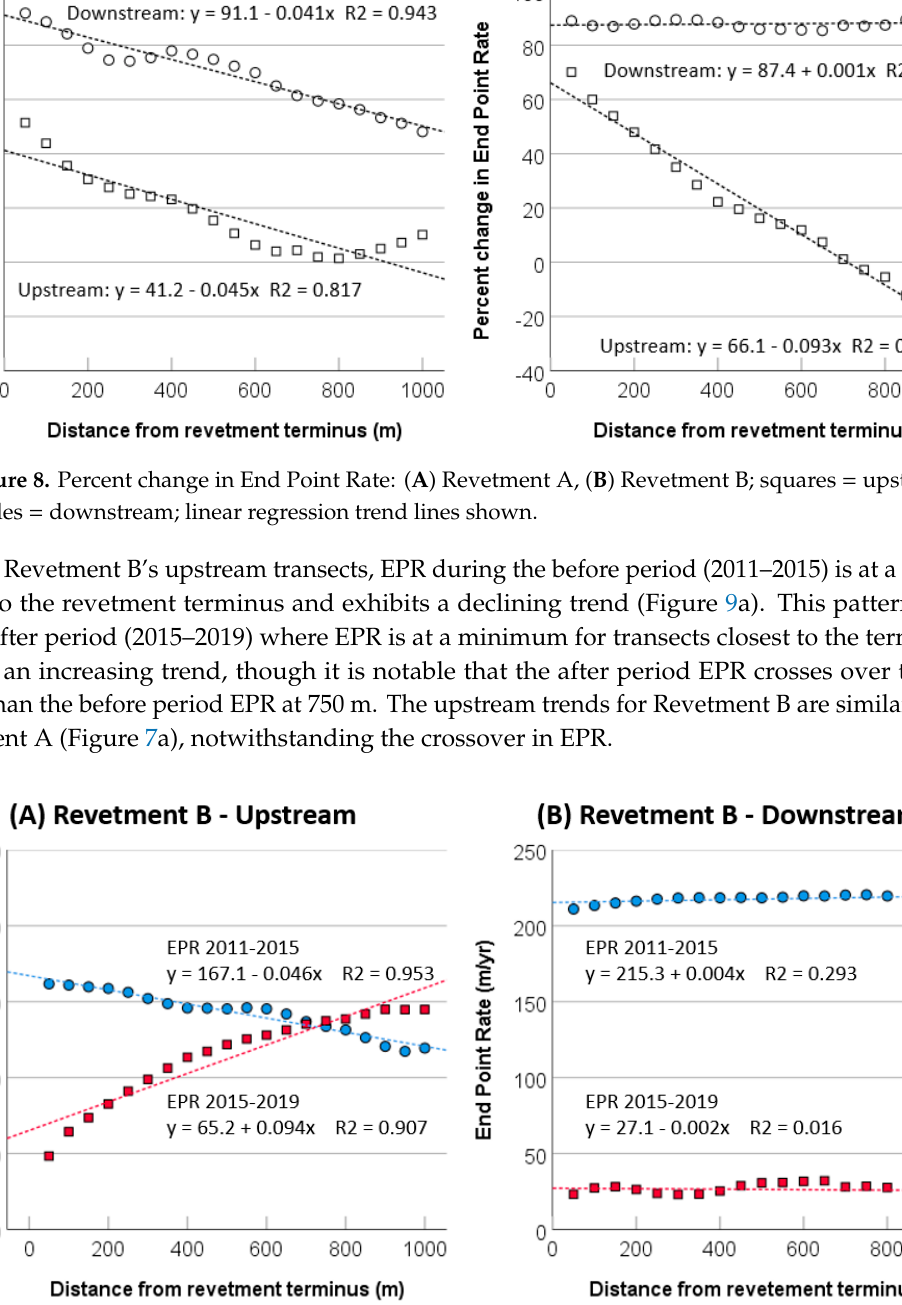
Figure 9. Revetment B End Point Rate: ( A ) upstream, ( B ) downstream; circles = EPR for 2011–2015, squares = EPR for 2015–2019; linear regression trend line shown.